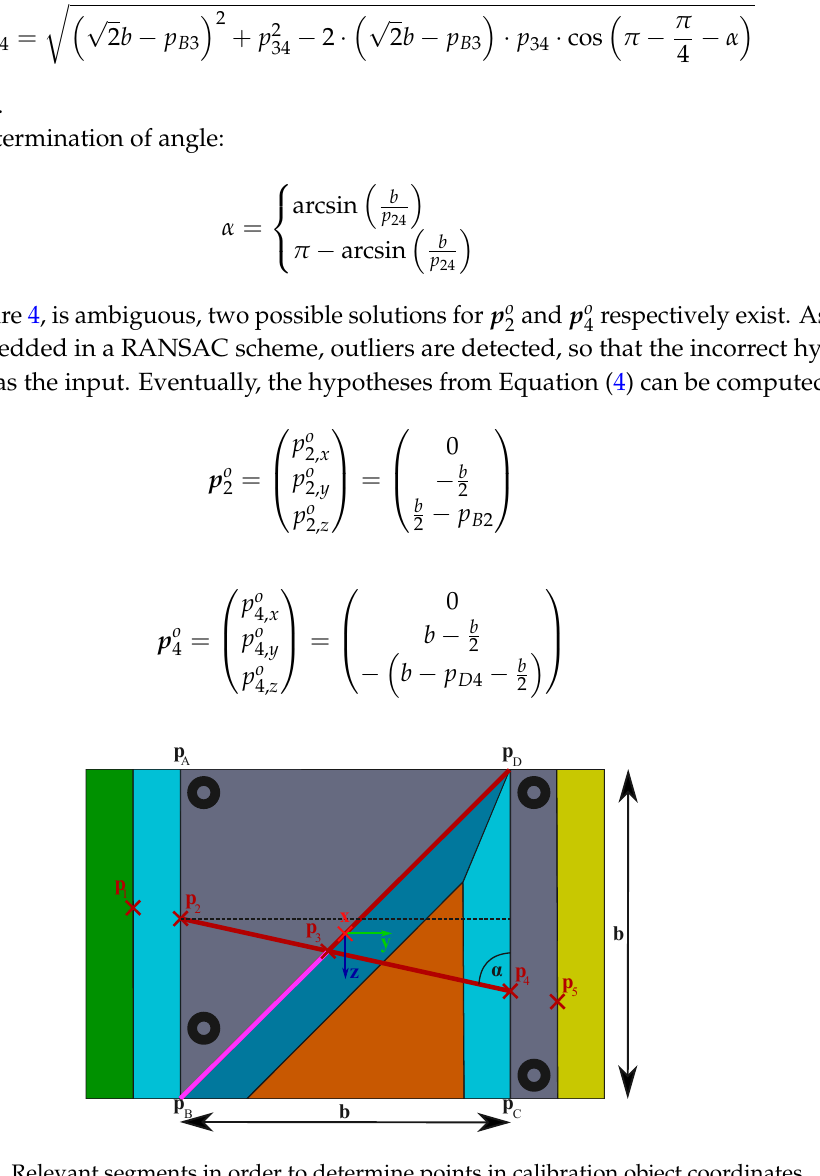
Figure 4. Relevant segments in order to determine points in calibration object